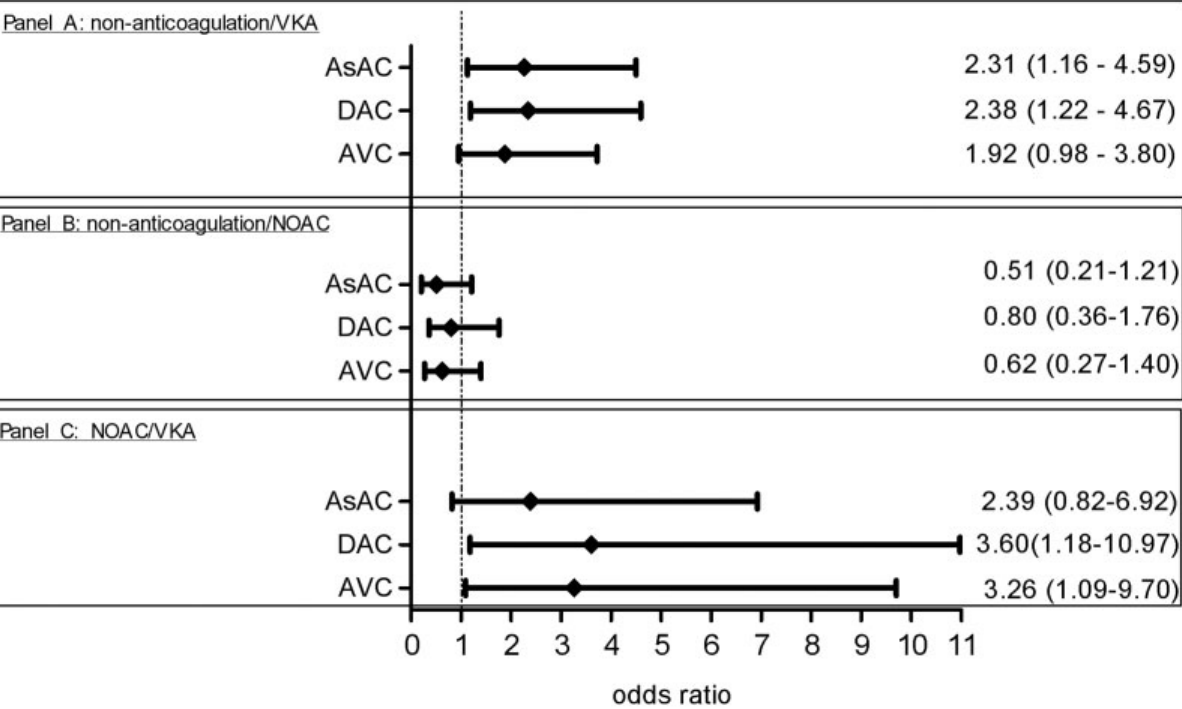
Fig. 2 AsAC,DAC,and AVC inpropensity score – adjusted regressionanalyses(oddsratio[95%CI]). ( PanelA ) Non-anticoagulation(reference)versusVKA. ( PanelB )Non-anticoagulation(reference)versusNOAC.( PanelC )NOAC(reference)versusVKA.AsAC,ascendingaorticcalci fi cation;DAC,descendingaortic calci fi cation; AVC, aortic valve calci fi cation; VKA, vitamin K antagonist; NOAC, non – vitamin K antagonist oral anticoagulant.